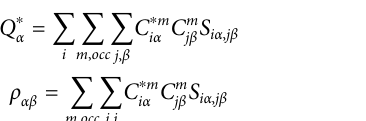
Frontiers in Materials |